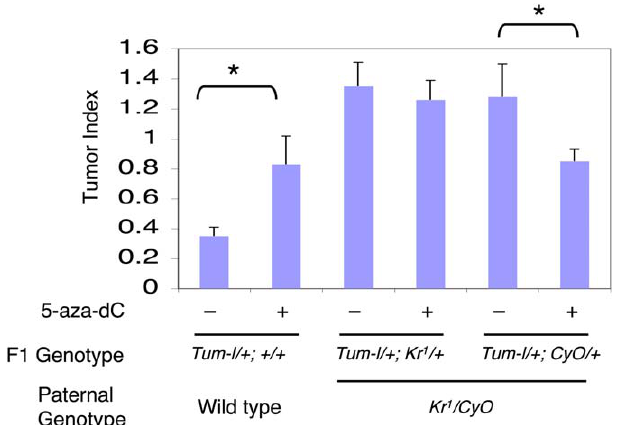
Figure 5. Effects of the Methyltransferase Inhibitor 5-Aza-dC on Tumorigenesis Wild-type or Kr 1 /CyO flies were raised in food supplemented with ( þ ) or without ( (cid:2) ) 5-aza-dC. Male flies of indicated genotypes were then crossed to hop Tum-l/ þ females and the F1 was raised in regular food in the absence of 5-aza-dC. F1 flies of the indicated genotypes were scored for the presence of melanotic tumors. TIs are shown as average 6 standard deviation. * indicates significant difference by Chi-squared